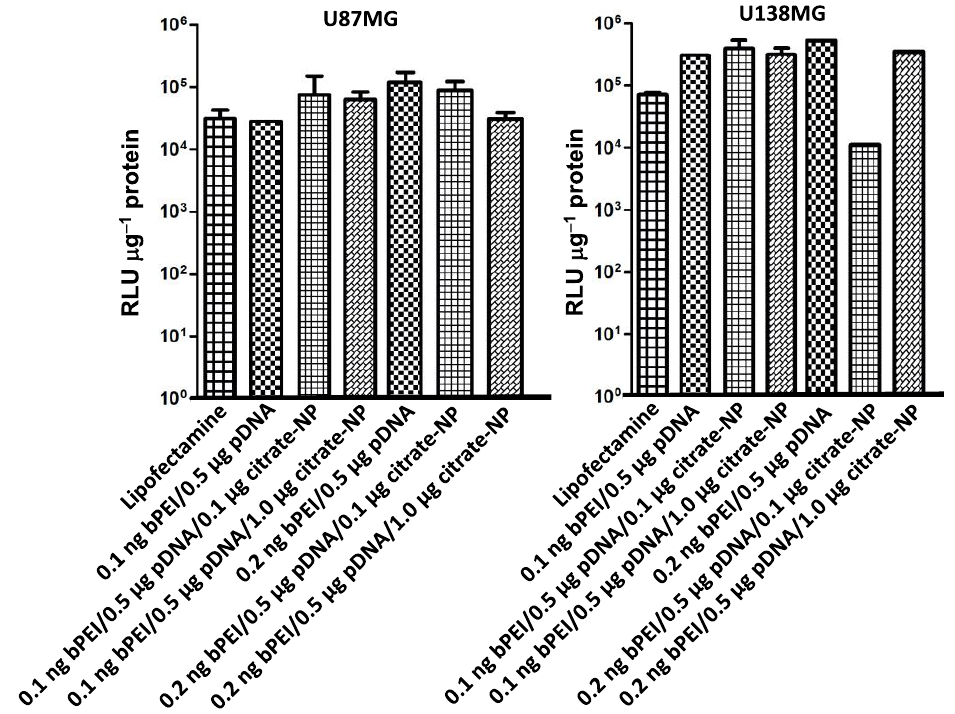
Figure 3. Luciferase expression of different composite transfected to U87MG (left) and U138MG (right) glioblastoma cells for 5 h. The amount of plasmid pRL-CMV pDNA of all composites was fixed at 0.5 μg/well. The amount of lipofectamine was fixed at 2.0 μg/well. Renilla activities (RLU) were measured and normalized against total cellular protein per well.